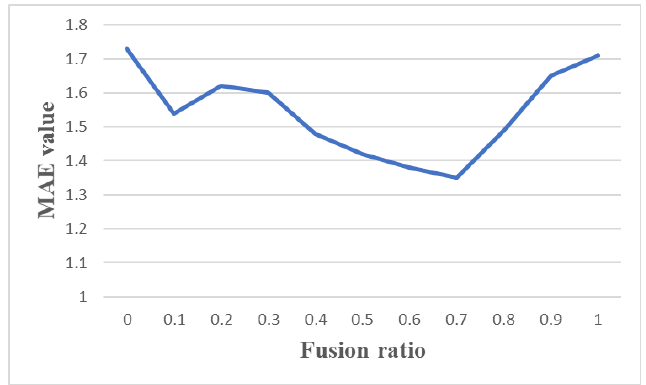
Figure 7. MAE Values at different fusion ratios.